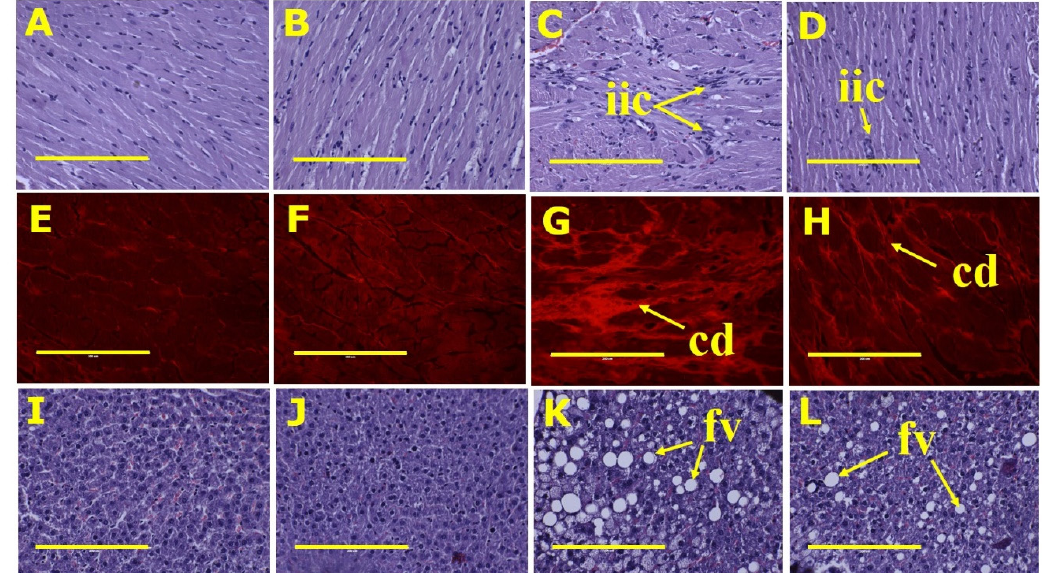
Figure 3. Heart histology: infiltrated inflammatory cells (top row—“iic”) using haematoxylin and eosin stain; collagen deposition (middle row—“cd”) using picrosirius red stain. Liver histology: fat vacuoles (bottom row—“fv”) using haematoxylin and eosin stain in corn starch diet-fed rats ( A,E,I ); corn starch diet-fed rats supplemented with Saskatoon berry powder ( B,F,J ); high-carbohydrate, high-fat diet-fed rats ( C,G,K ); and high-carbohydrate, high-fat diet-fed rats supplemented with Saskatoon berry powder ( D,H,L ). The yellow scale bar is 200 µm (20×).